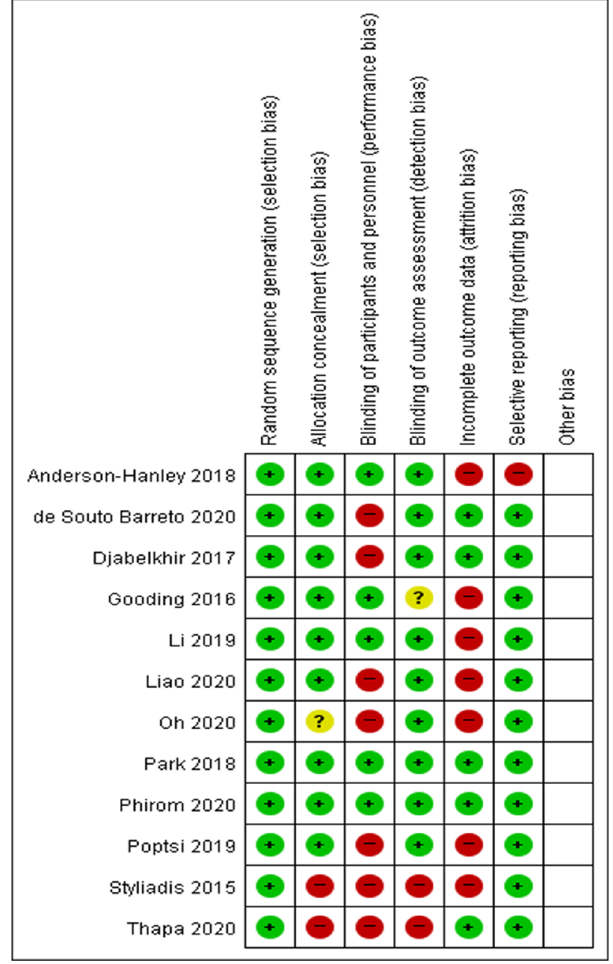
Figure 2. Risk of bias assessments. Green: Low risk, Yellow: Unclear, Red: High risk.